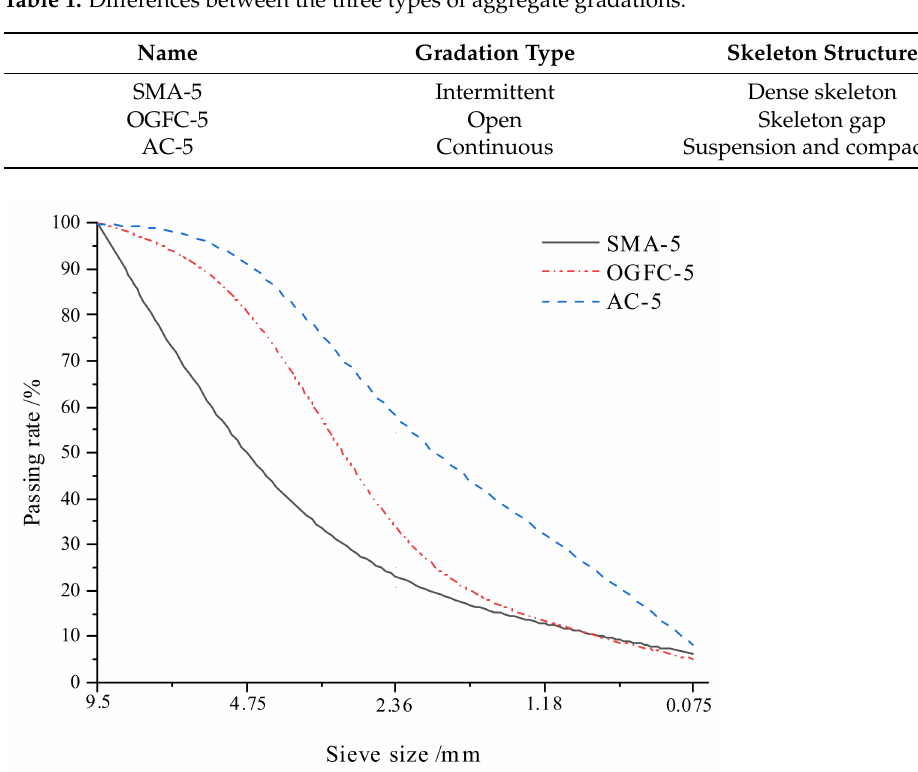
Table 1. Differences between the three types of aggregate gradations.